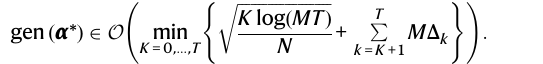
Fig. 1| VarioustypesofQuantum MachineLearning Models(QMLMs). Panel( a ) depicts a basic QMLM with T =6 independently parameterized gates. The gray boxes illustrate some global evolutions that are not trainable. Panel ( b ) shows a gate-sharing QMLM with T =2 independently parameterized gates, each gate is repeatedlyusedfor M =3times.Inpanel( c ),wedepictamulti-copyQMLM.Wetake measurementdatafrom M roundsofabasicQMLMwith T =6parameterizedgates and post-process the measurement outcomes to produce an output. Running M copiesof abasicQMLMwith T gates is equivalentto running agate-sharing QMLM